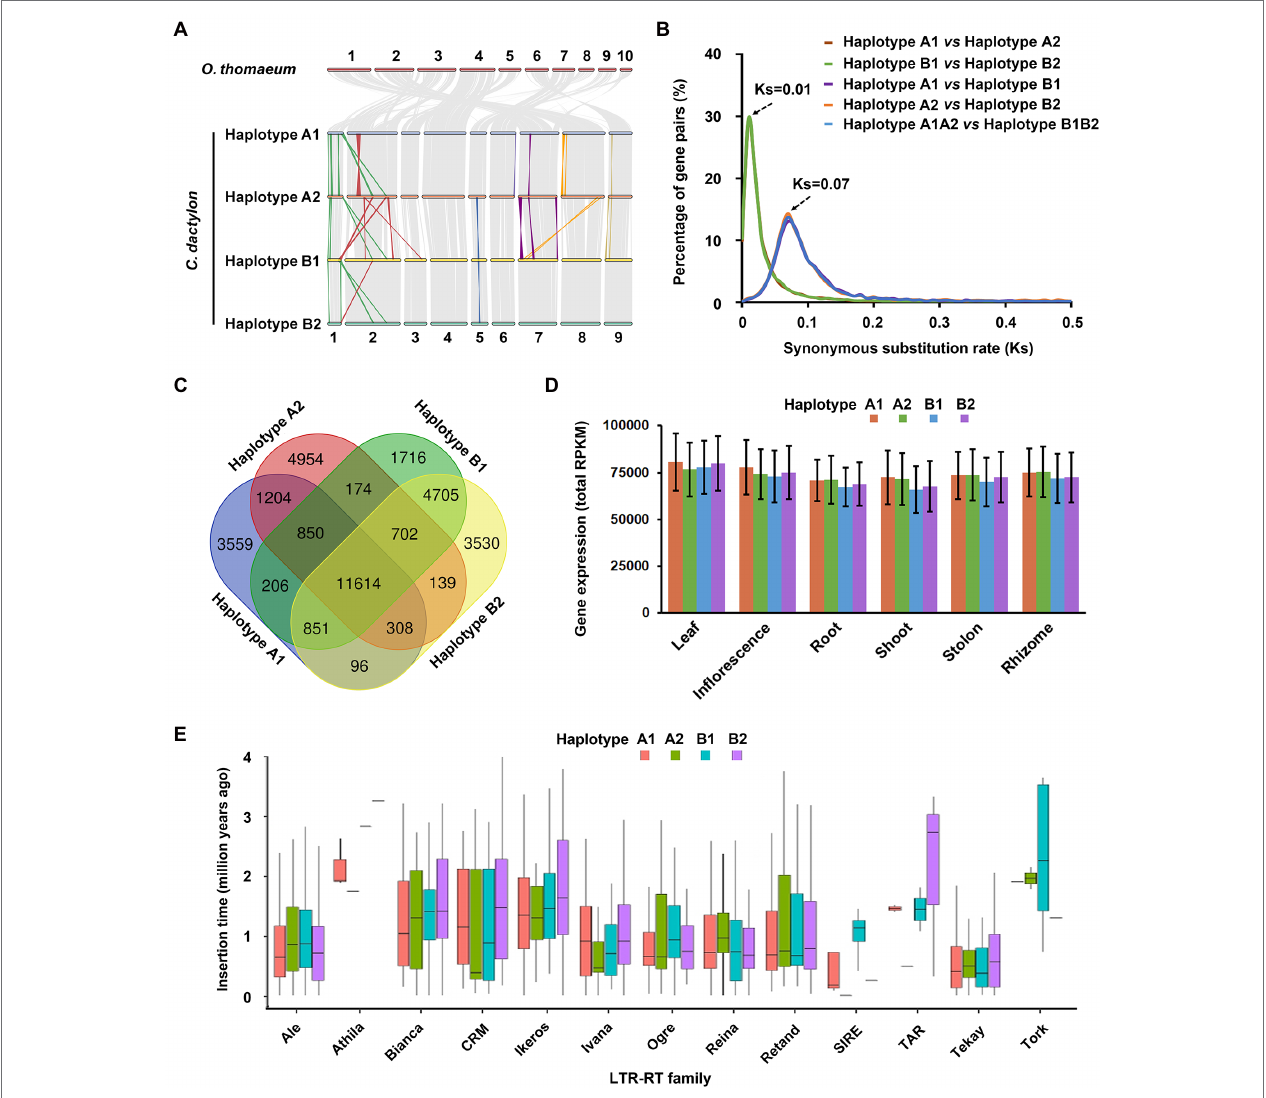
FIGURE 3 | Subgenomic organization and variation of C. dactylon. (A) Schematic representation of syntenic genes among O. thomaeum and four haplotypes of C. dactylon . Gray lines depict homologous genome blocks. Color lines indicate inversion and translocation on the homologous chromosomes. (B) Distribution of synonymous nucleotide substitution levels (Ks) of syntenic gene pairs between different haploptypes of C. dactylon. (C) Venn diagram of alleles and orphan genes in the four haploptypes of C. dactylon . (D) Total gene expression level of the 11,614 four-copy alleles based on their relative expression level in six organs of C. dactylon . Error bars represent SE of the three sequencing replicates. (E) Box plots showing the insertion dynamics of 13 LTR-RT families in four haploptypes of C. dactylon. Box boundaries indicate the 25th and 75th percentiles of the insertion time and whiskers extend to 1.5 times the interquartile